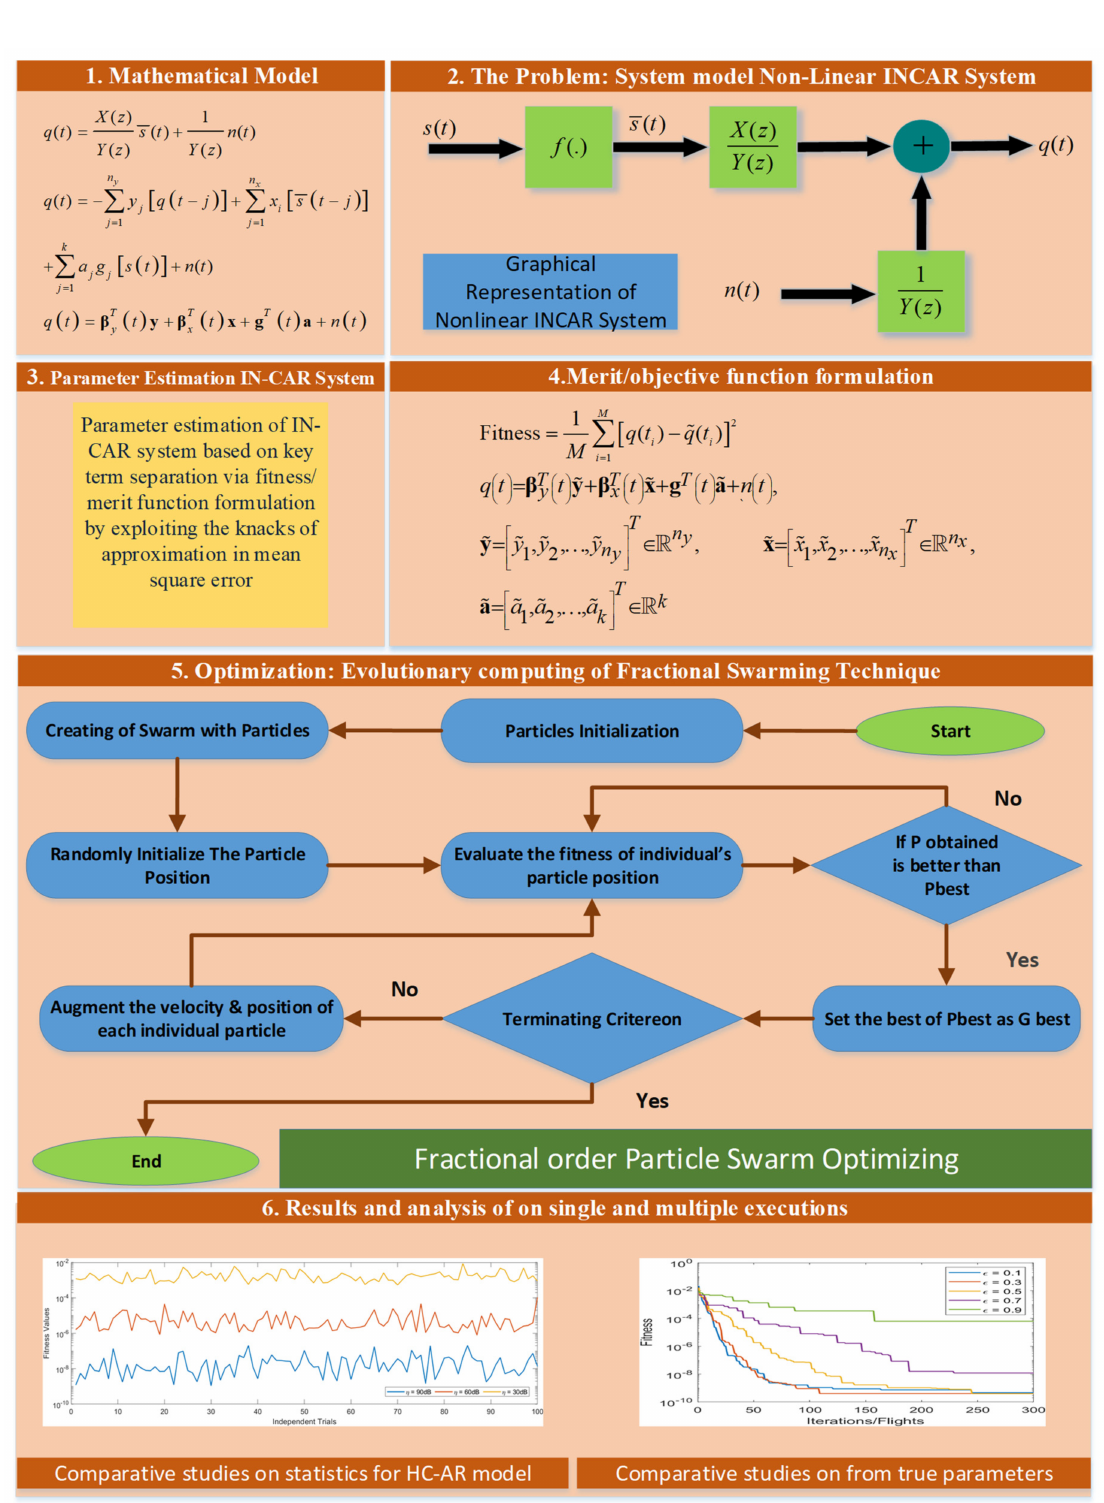
Figure 1. Graphical abstract of the proposed study identifying IN-CAR system using